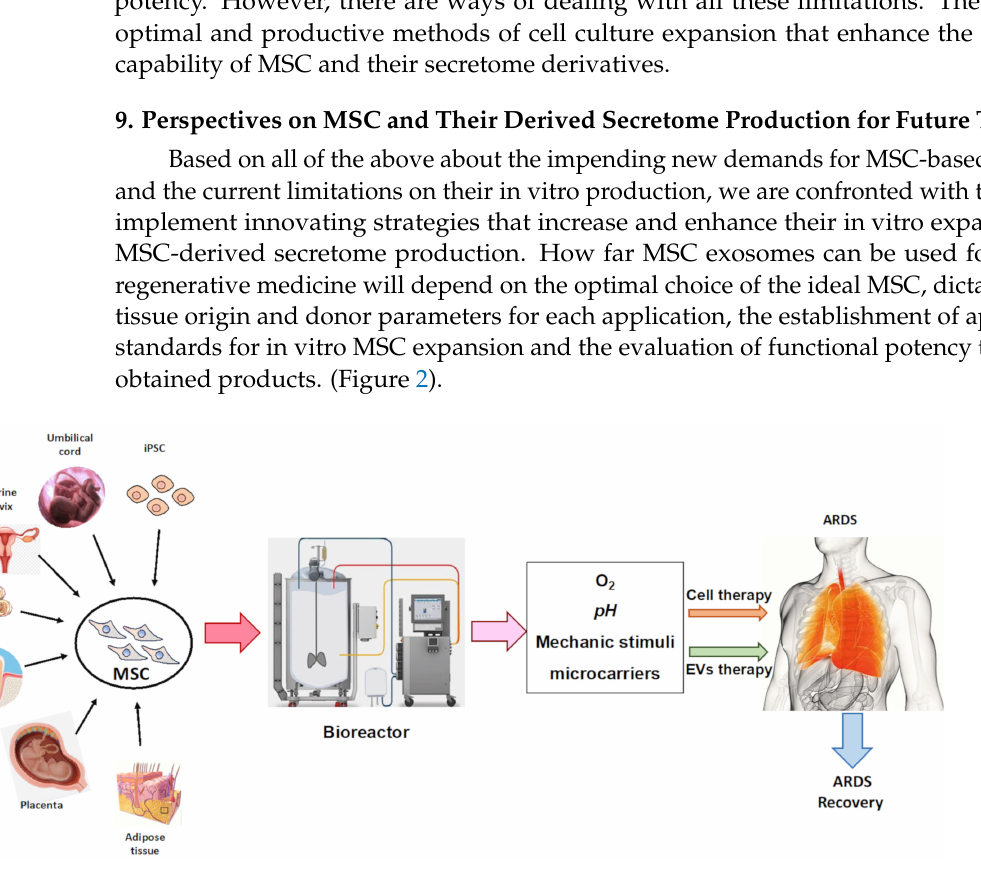
Figure 2. Mesenchymal stem cells (MSC) production strategies based on the source of MSC, the system used for in vitro expansion, culture cell conditions and the ultimate product for Acute respiratory distress syndrome (ARDS)